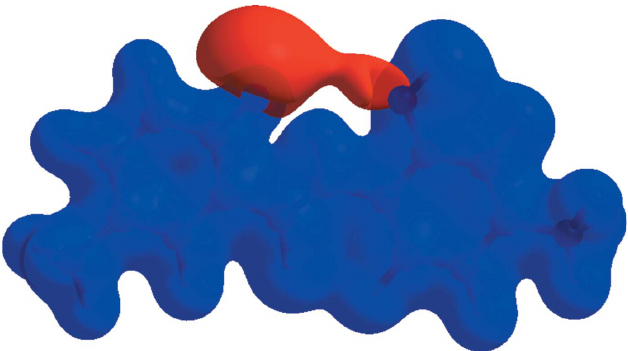
Figure 6 A view of the molecular electrostatic potential, in the range (cid:5) 0.0500 to 0.0500 a.u. calculated using the STO-3 G basis set in the range (cid:5) 0.050 to 0.050 a.u. within the Hartree–Fock level of